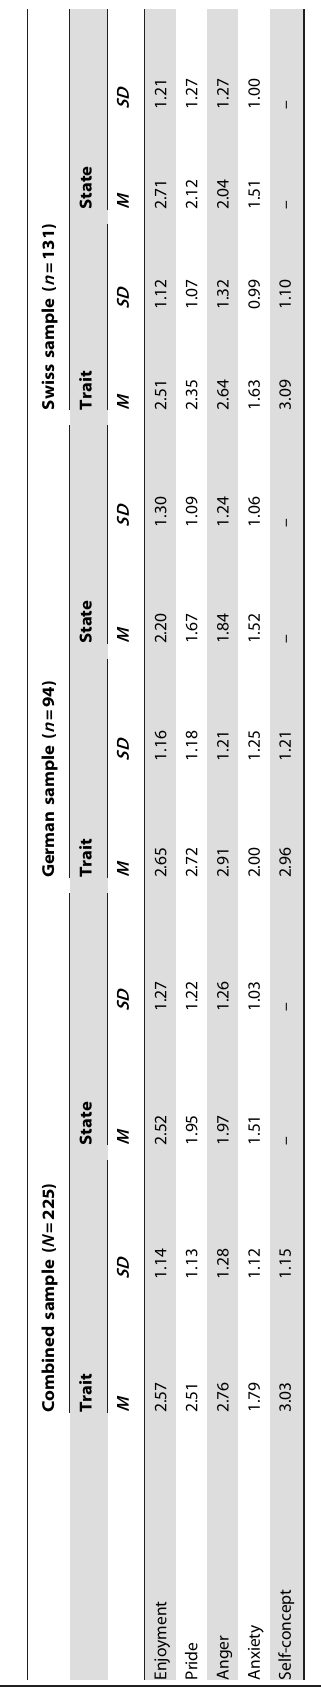
The results of the hierarchical linear regression for the four emotions of enjoyment , pride , anger , and anxiety are shown in Table 2. Further, the variance components are depicted in this table. We also calculated the explanatory power of self-concept with regard to the slope variance, that is, as a predictor of the trait-state discrepancy [46]. Model 1 – Combined model. In Model 1 the coefficient for the intercept ( c 000 ) is to be interpreted as the mean emotion score when all other variables in the model are equal to zero. Thus, this represents the respective mean state emotion for a student who has a mean self-concept. The mean state score for the emotion of enjoyment was 2.52, 1.95 for pride , 1.97 for anger , and 1.50 for anxiety . The coefficient for the Trait dummy ( c 100 ) is positive and significant for every emotion with the exception of enjoyment , for which no significant difference was found. Thus, with one exception, trait emotions are rated higher than state emotions (Hypothesis 1). Regression weights for the Self-concept x Trait ( c 110 ) interaction indicate the influence of self-concept on the discrepancy between trait and state emotional assessments. As expected, for enjoyment (.23) and pride (.30) the coefficients were positive, whereas for anger ( 2 .34) and anxiety ( 2 .33) the coefficients were negative. This suggests that high self-concept in mathematics is associated with higher discrepancies between trait and state enjoyment and pride and smaller discrepancies between trait and state anger and anxiety (Hypothesis 2). Models 2 and 3 – German model and Swiss model. In order to account for differences between German and Swiss samples, we calculated models for each of the four emotions with a country dummy for Switzerland (CH_dummy; Model 2) and Germany (DE_dummy; Model 3). With regard to our first hypothesis, trait emotions were rated significantly higher than state emotions. In the German model (Model 2), coefficients for the Trait dummy ( c 100 ) were 0.42 for enjoyment , 1.02 for pride , 1.09 for anger , and 0.48 for anxiety . Coefficients in the Swiss model were